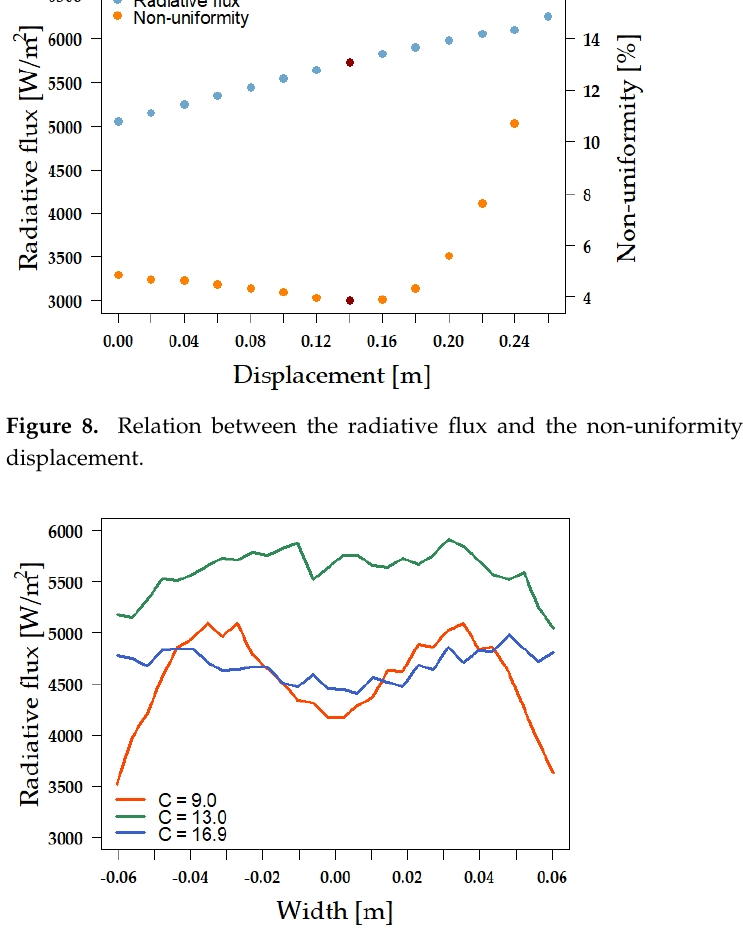
Figure 9. Cross-section radiative flux distribution for four different concentration ratios.